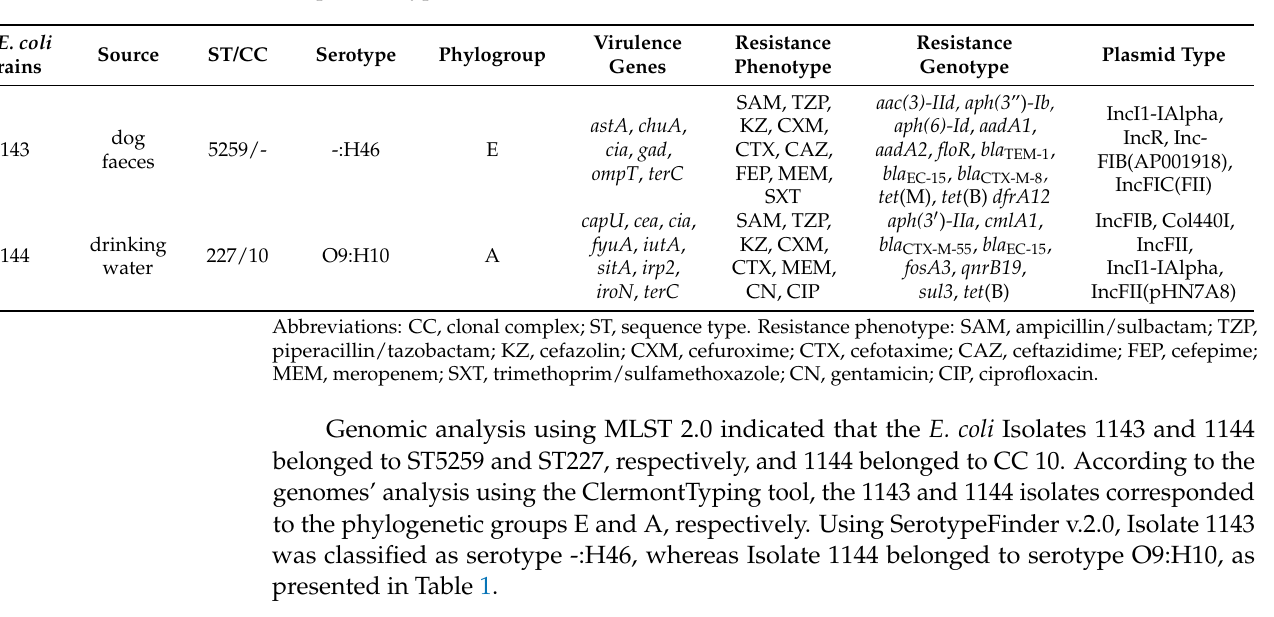
Table 1. Characterisation of the ESBL-producing E. coli isolates according to origin and source, sequence type and clonal complex, serotype, virulence genes, resistance phenotype and genotype, and plasmid